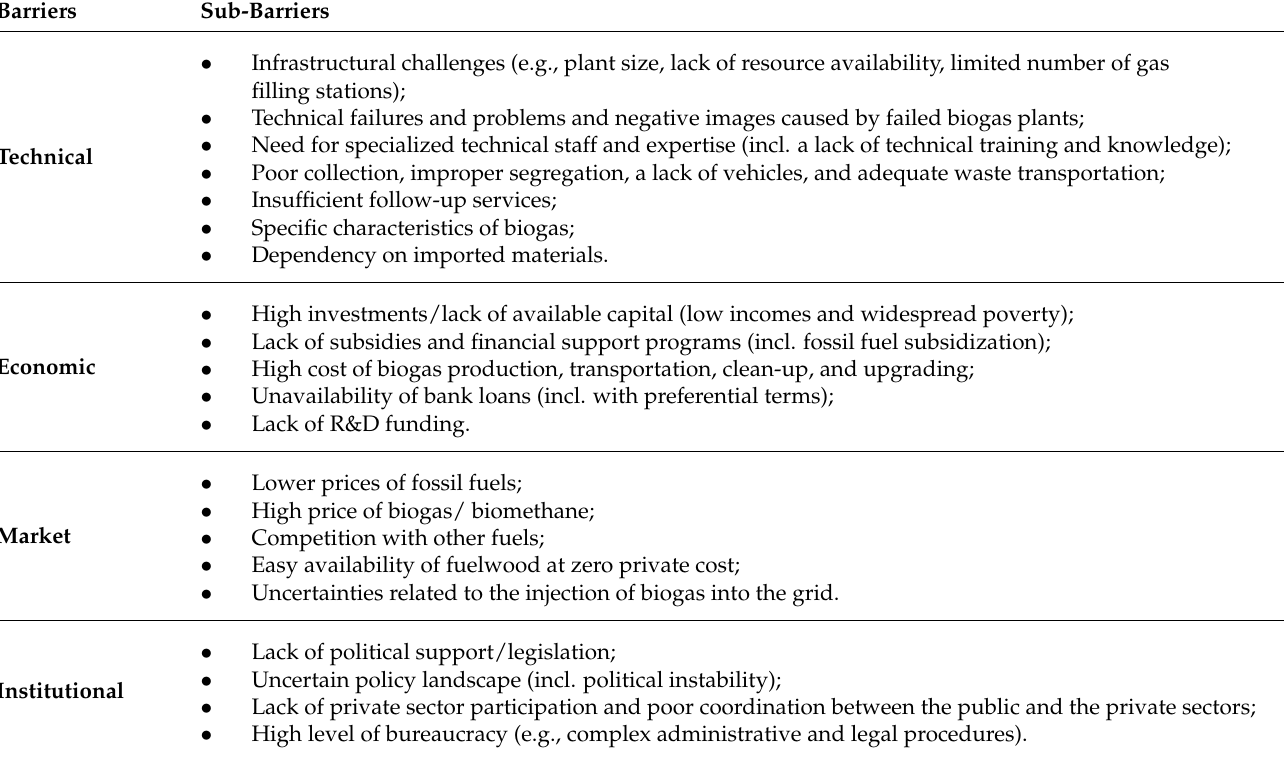
Table 2. Challenges faced by the implementation of AD in various countries. Copyright 2019 by Elsevier